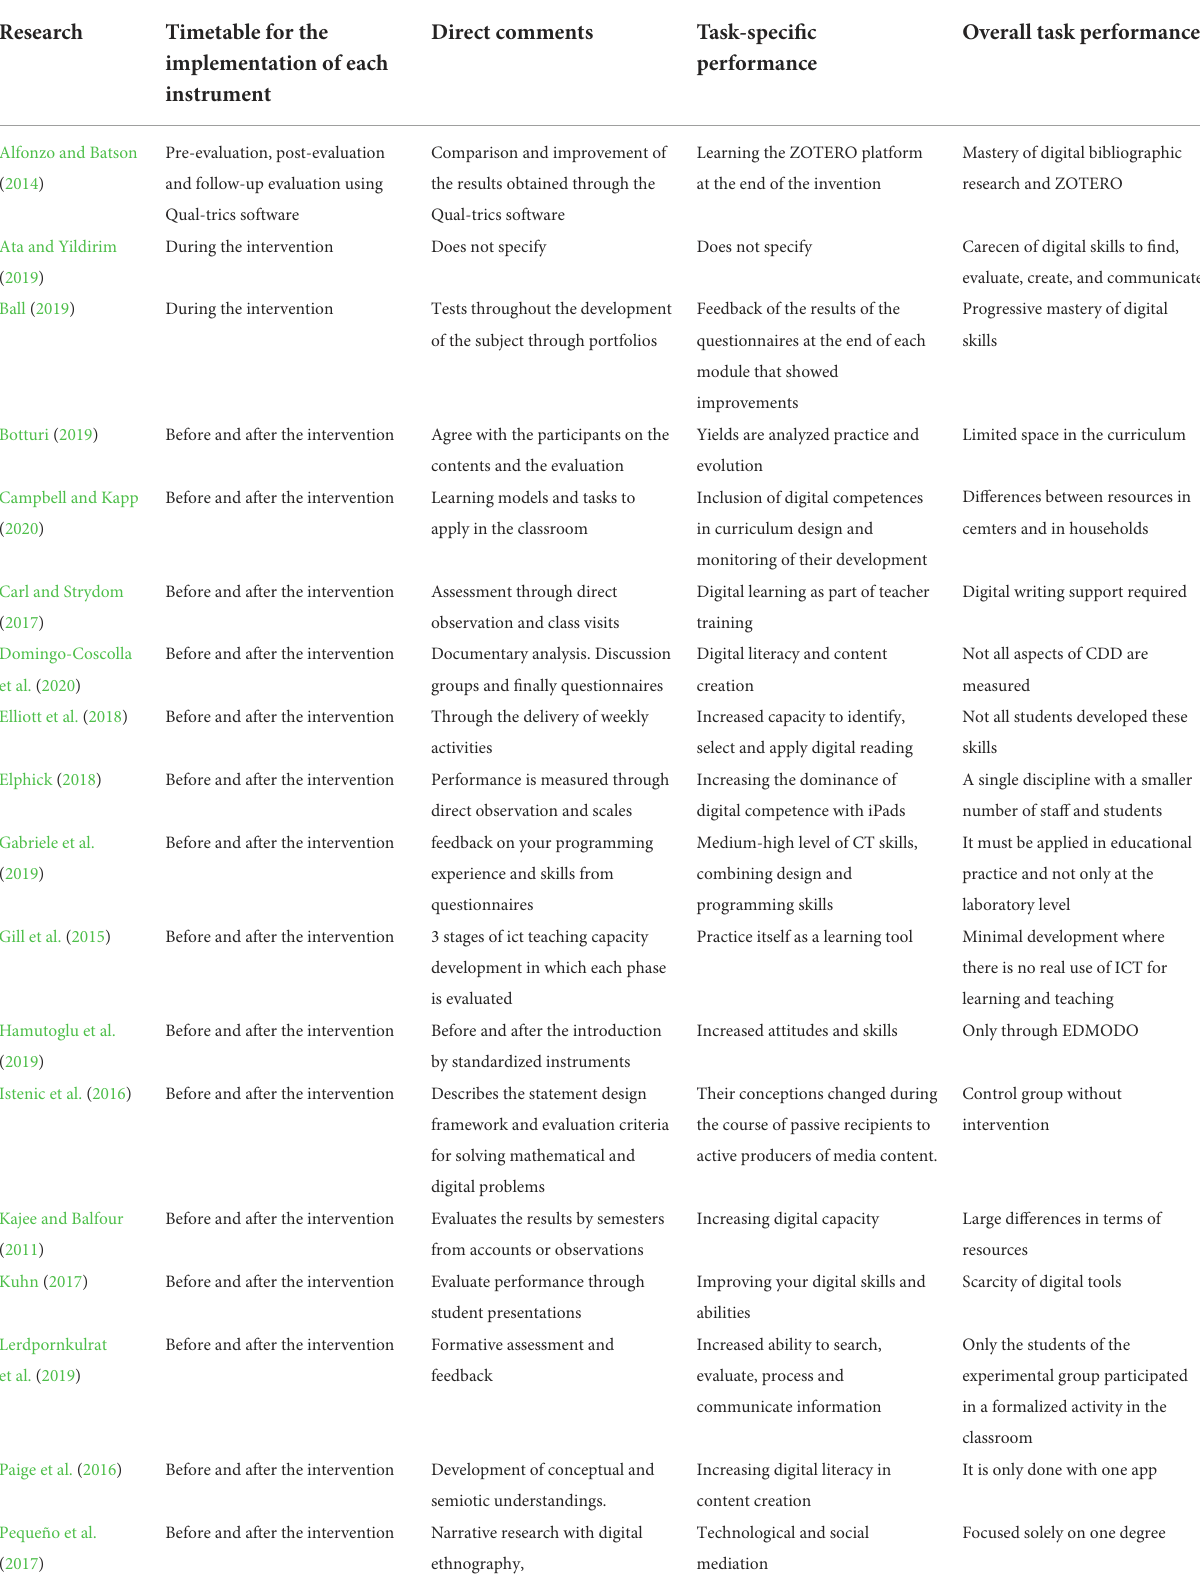
TABLE 3 Assessment intervention in the reviewed studies.